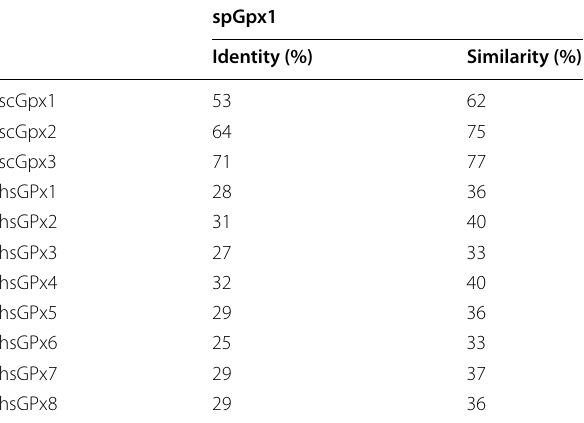
Table 1 Sequence comparison of spGpx1 to S. cerevisiae and human